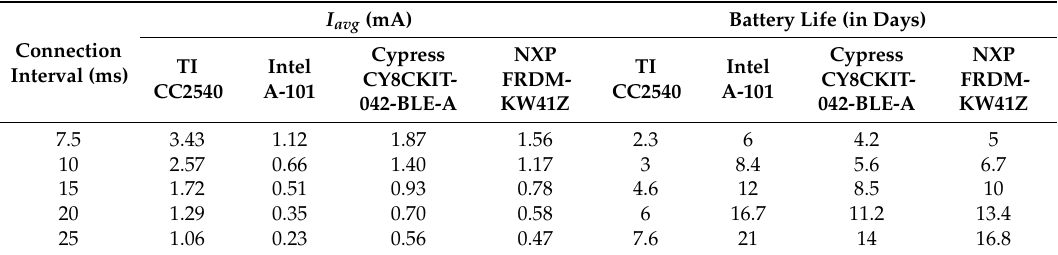
Table 7. Current consumption and expected battery life for each platform configured as PD for lower connection intervals and a corrected battery capacity of 190